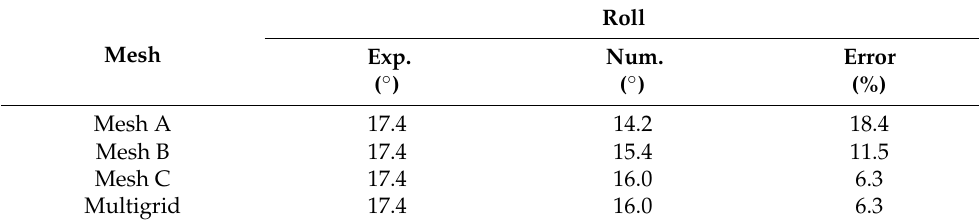
Table 4. Errors of motion amplitude using the different